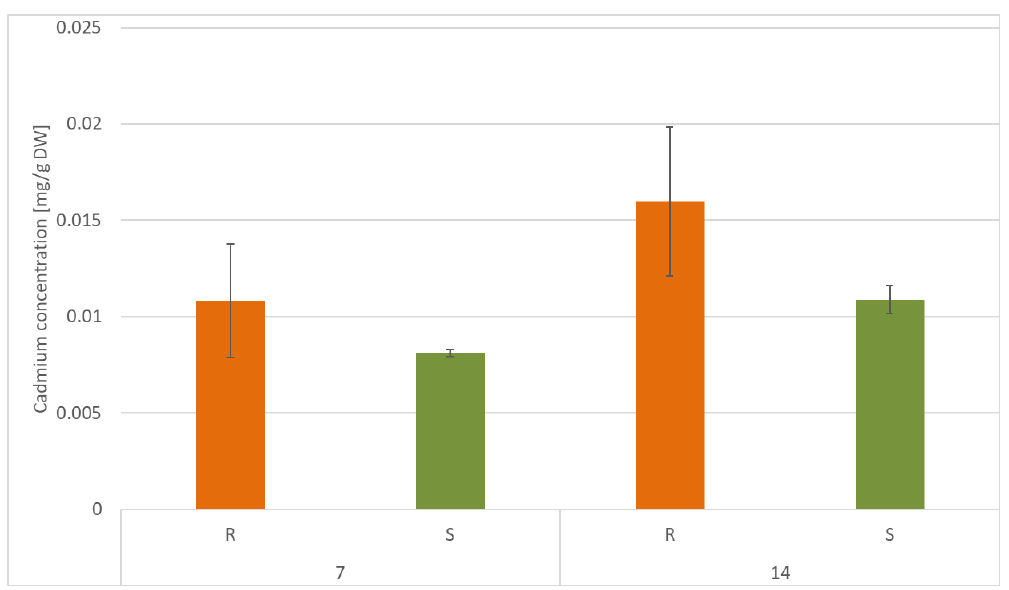
Figure 15. Cadmium concentration in roots (R) and shoots (S) of C. officinalis plants after 7 and 14 days of cultivation in Cd- contaminated soil. Values represent mean ± SD.